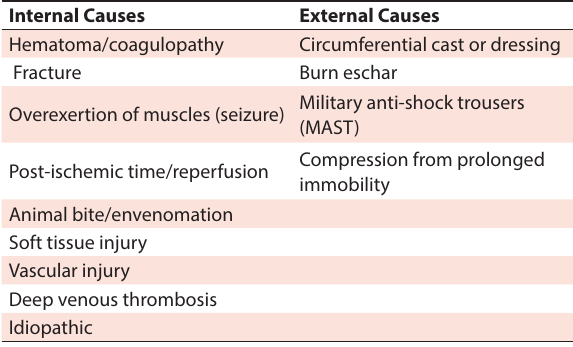
Table 1. Causes of Acute Compartment Syndrome